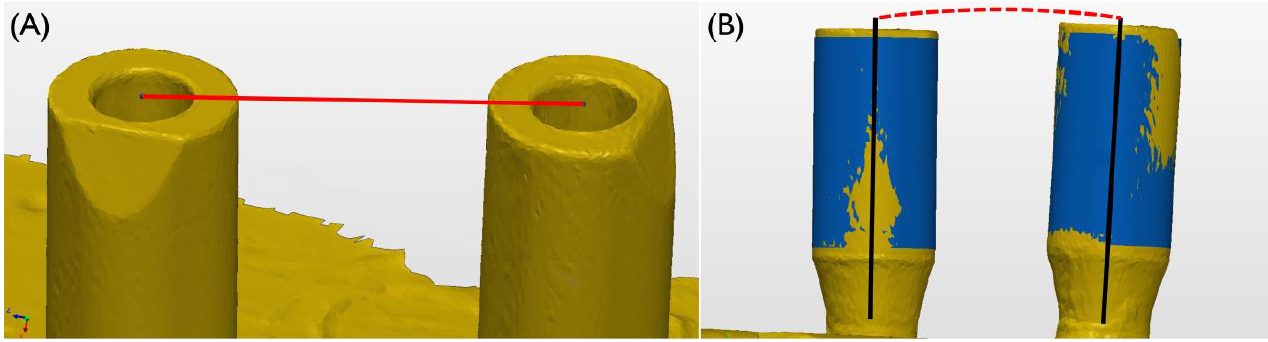
Figure 2. ( A ) The distance between the centers of the top surfaces of the two SBs was measured. ( B ) The angle between the axes of the two SBs was measured.